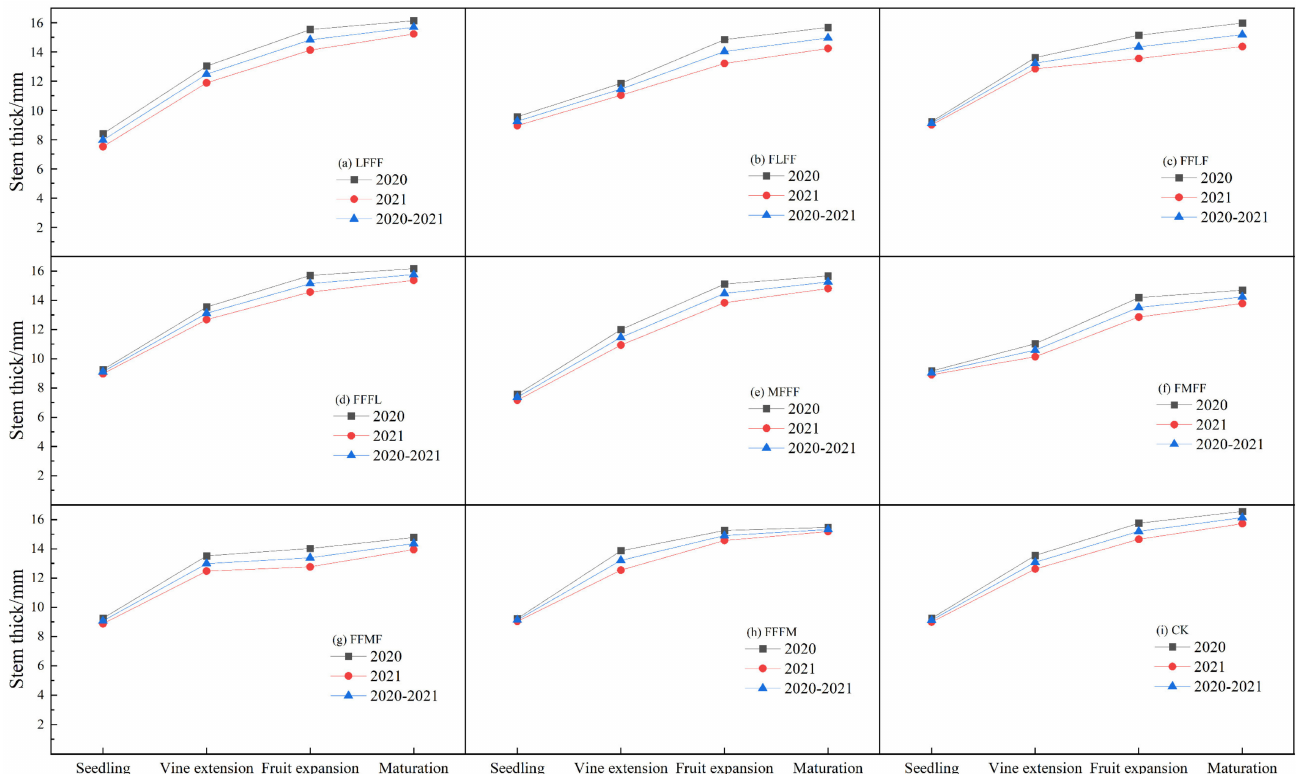
Figure 4. Effects of drip irrigation under mulch on the stem thickness of